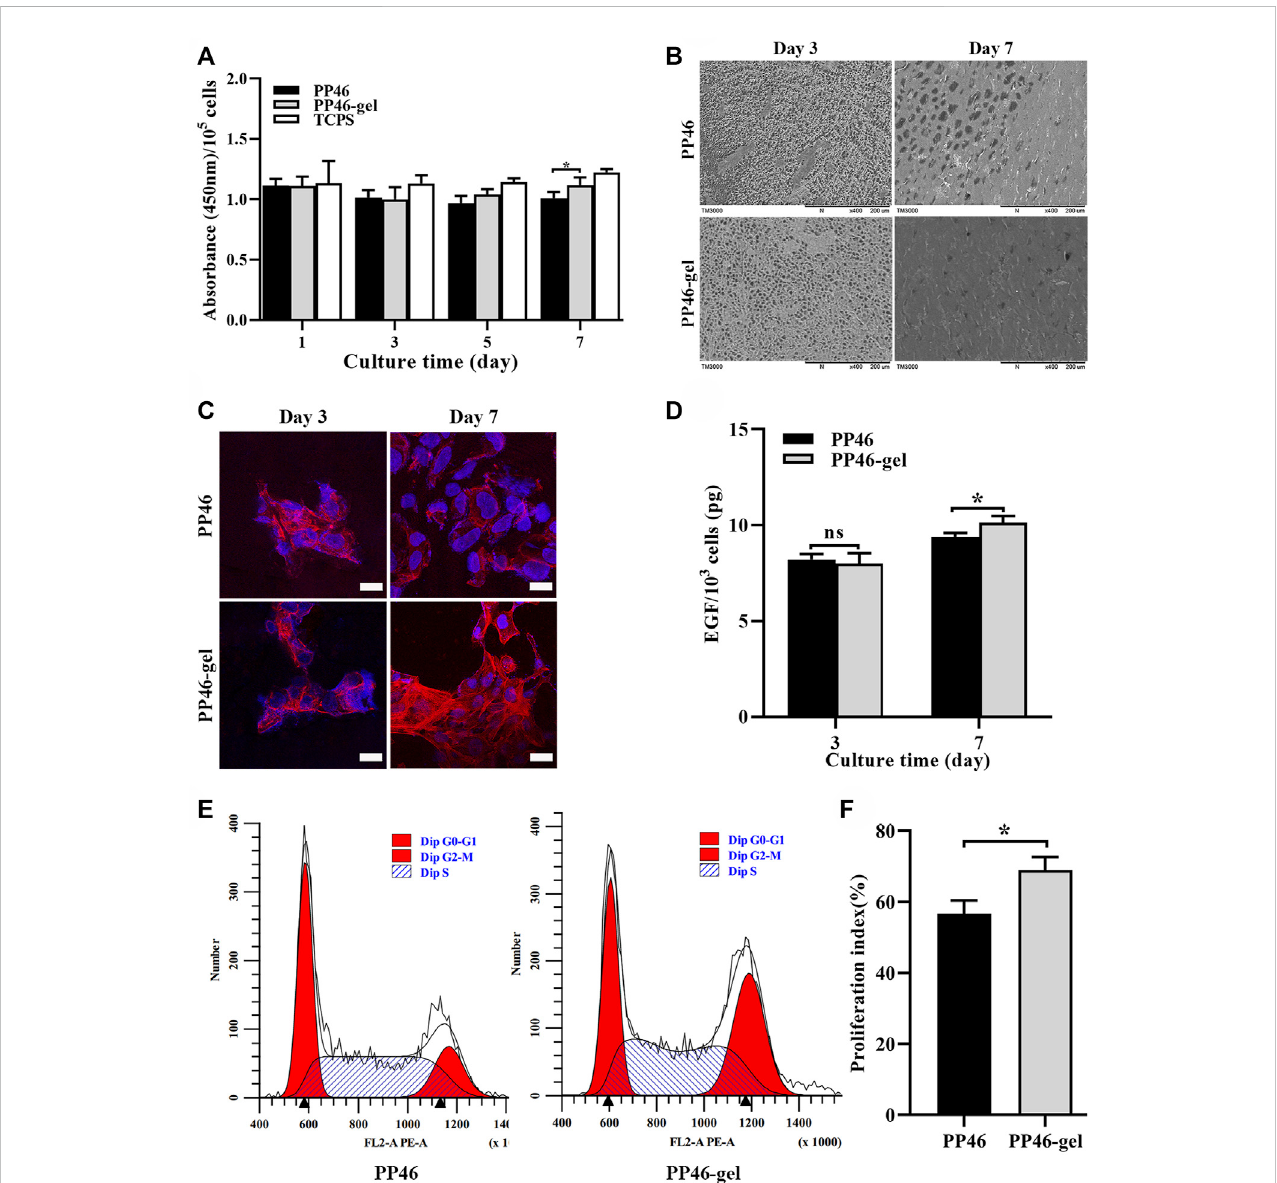
FIGURE 3 Proliferation of HUCs on the scaffold PP46 and PP46-gel. (A) Absorbance at a wavelength of 450 nm divided by the number of cells cultivated on the corresponding scaffolds. The cell number was measured with a hemocytometer. (B) Distribution of HUCs on the scaffolds observed under SEM. (C) Morphology ofHUCsstainedwithF-actin(rhodamine-phalloidin,red)andnuclei (DAPI,blue).Scalebar,20 μ m. (D) Quanti fi cationofEGFsecretedbycellson scaffolds PP46 or PP46-gel cultivated for 3 and 7 days, respectively. The value was divided by the number of cells cultivated on the corresponding scaffolds. (E) Cell cycleinvestigation tested using a fl ow cytometer. (F) Cellproliferationindex (%)calculated from E. All data arepresented as mean± SD (* p < 0.05; ns: p >